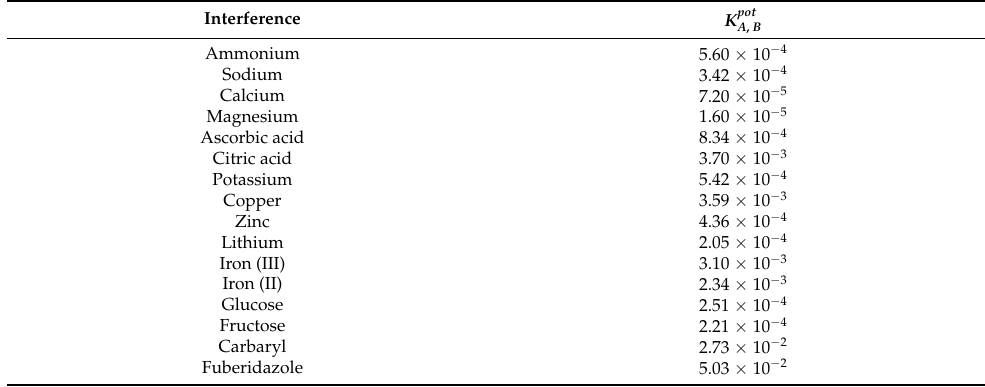
Table 3. Potentiometric selectivity coefficients of the new MWCNT-OSO 3 − TBZ + sensor obtained using the fixed interference